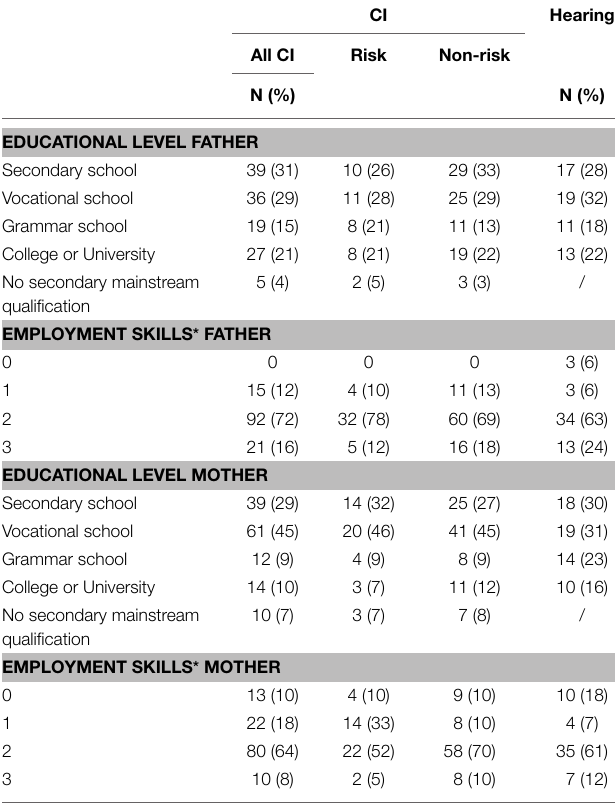
TABLE 3 | Educational level and employment skills of n = 136 parents of CI users including 46 CI users with indication for additional handicaps and non-classifiable persons (“risk group”) and 94 CI users without additional handicaps (“non-risk group”) and n = 60 parents of normally hearing peers (matched by age, gender, and social